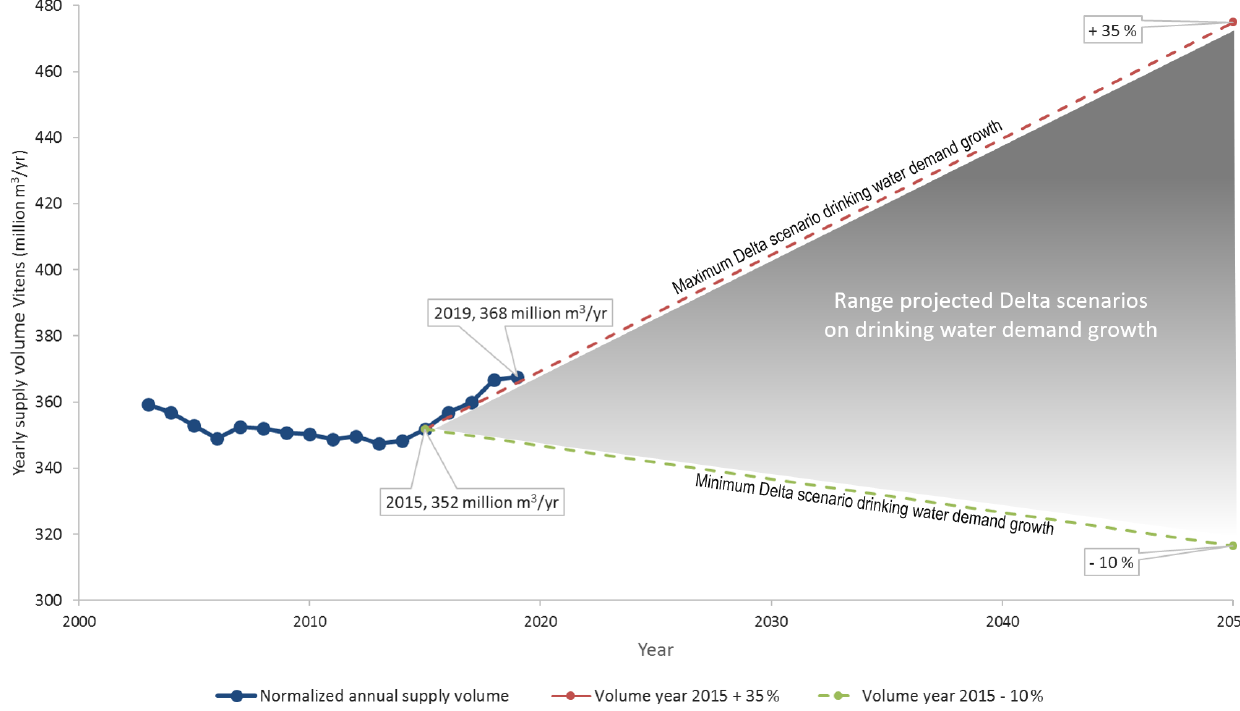
Figure 3. Development of the normalized annual drinking water volume supplied by Vitens (drinking water supplier), the Netherlands, 2003– 2019 (Van Engelenburg et al., unpublished, 2020), compared to the projected Delta scenarios on drinking water demand growth (Wolters et al., 2018), ranging between a decrease of 10% and an increase of 35% in 2050 compared to 2015. The normalized annual drinking water supply volume excludes the impact of extreme weather conditions on the actual supplied annual volumes of drinking